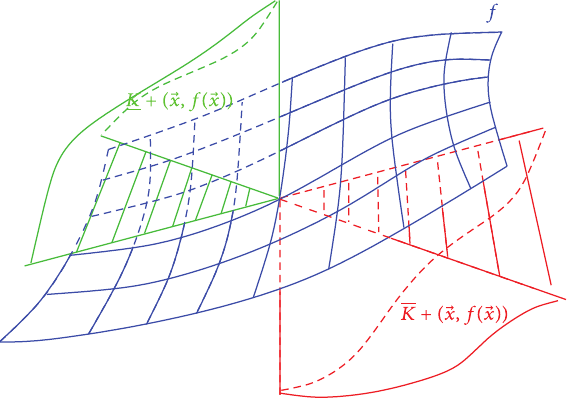
Figure 6: Example of 𝐾 + ( ⃗𝑥, 𝑓( ⃗𝑥)) and 𝐾 + ( ⃗𝑥, 𝑓( ⃗𝑥))